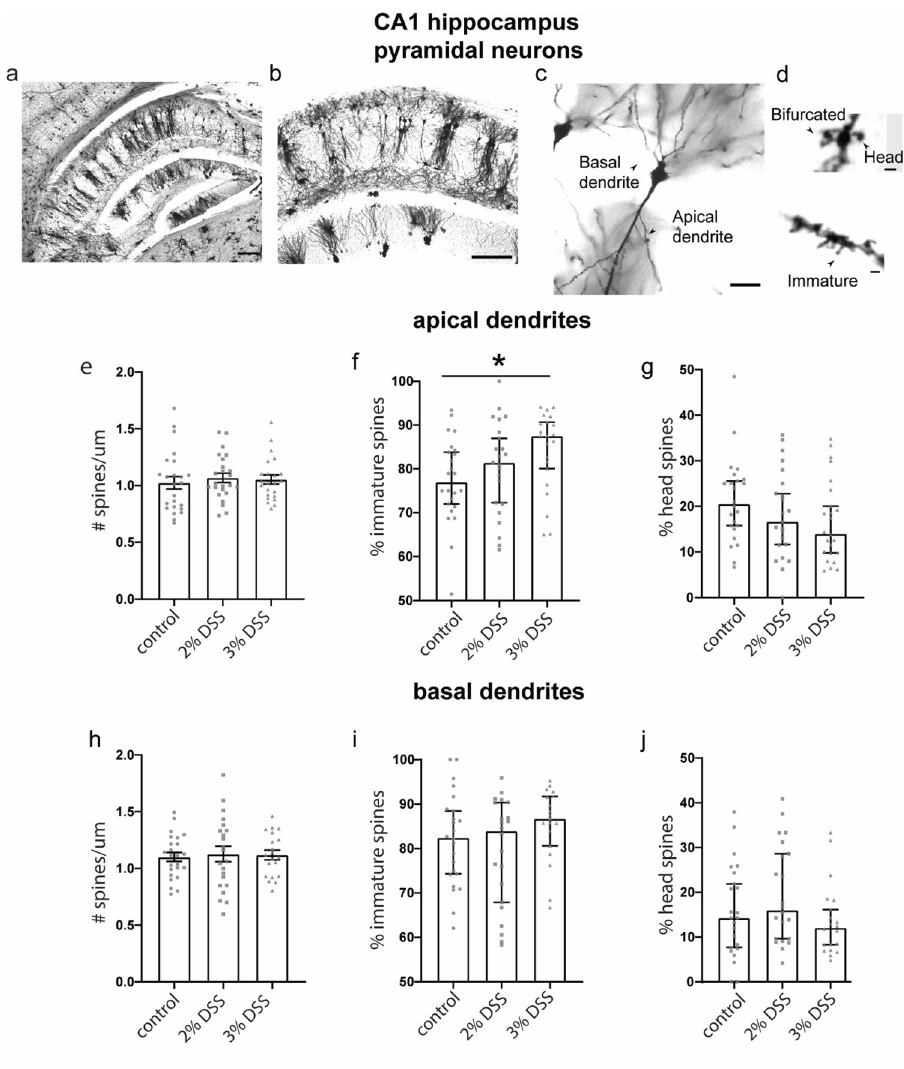
Figure 2. Spine density and composition on basal and apical dendrites of CA1 neurons in the hippocampus. ( a ) Photomicrograph of Golgi labeled cells of CA1 region in the mouse hippocampus (scale bar: 200 µm). ( b ) Larger view of panel a (scale bar: 200 μm). ( c ) Representative image of CA1 neuron (scale bar: 25 µm). ( d ) Representative examples of spine morphologies in CA1 (scale bar: 1 µm). ( e ) Density of spines on apical dendrites in CA1; data shown are mean ± SEM. Proportion of immature spines ( f ) and head spines ( g ) on apical dendrites in the CA1; data shown are median ± 95% CI. ( h ) Density of spines on basal dendrites in CA1; data shown are mean ± SEM. Proportion of immature spines ( i ) and head spines ( j ) on basal dendrites in the CA1; data shown are median ± 95% CI. Density data analyzed by One-way ANOVA. Composition data analyzed by Kruskal Wallis with Dunn’s post-test to negative control; *p < 0.05. n = 20–24 dendrites, from 6 neurons, from 6 animals per